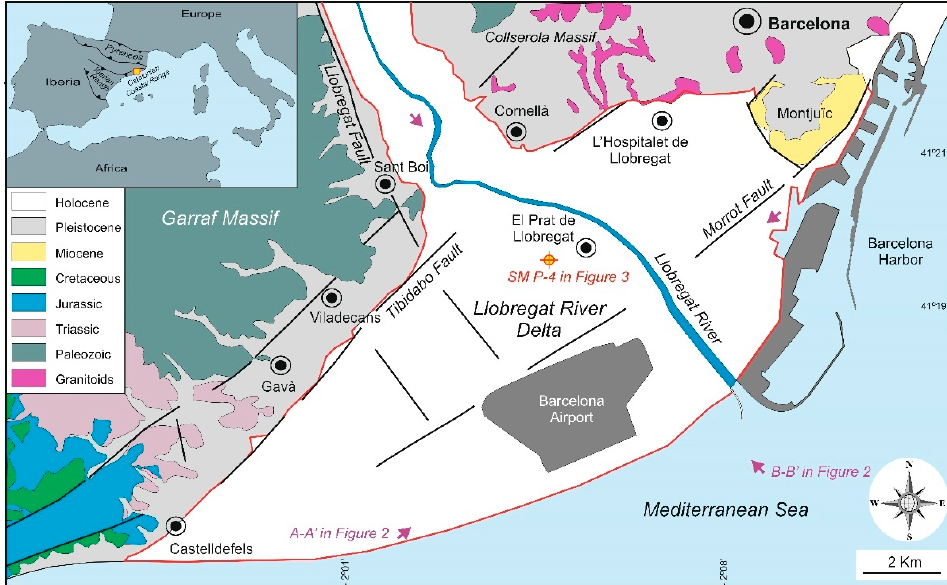
Figure 1. Geological sketch map of the LRD area (red line contour), modified and updated from Medialdea and Solé-Sabarís [4,5], Alonso et al. [6], and Gámez et al. [7]. Geological cross-sections A - A ’ and B - B ’ are displayed in Figure 2. Geotechnical borehole SM P-4 with granulometry data are displayed in Figure 3.